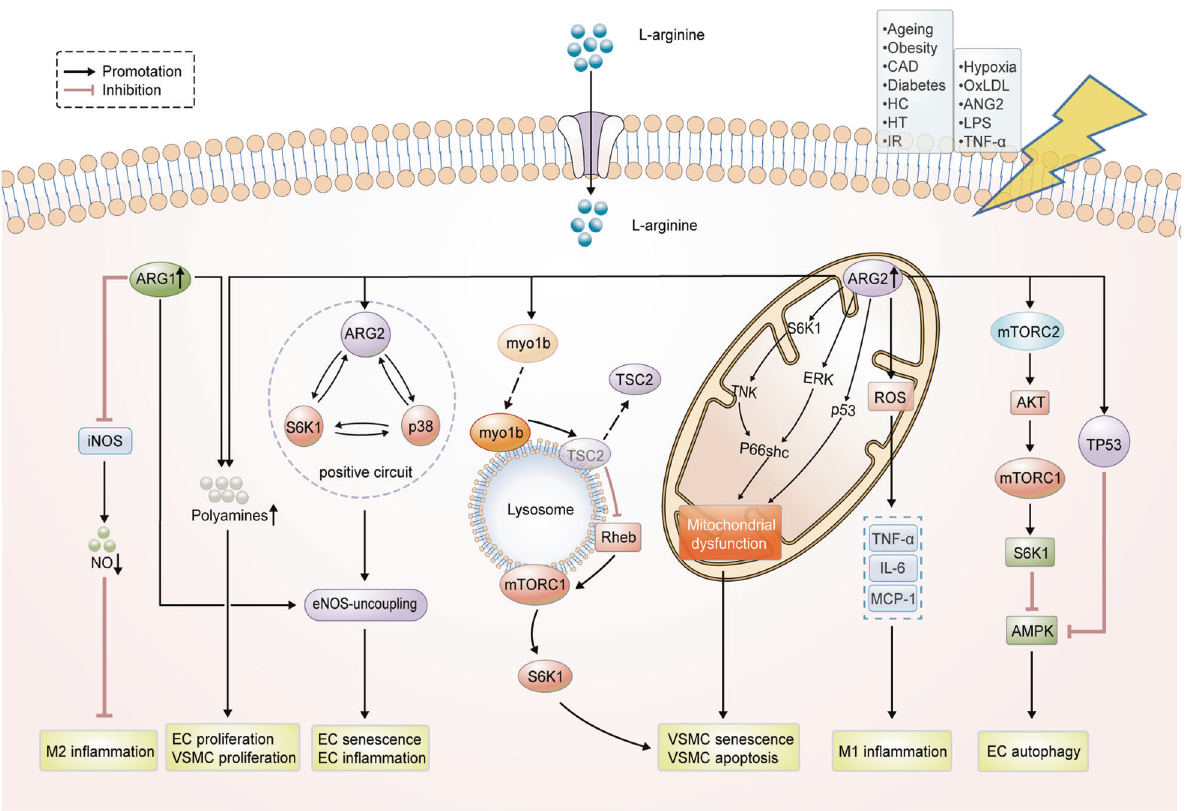
Fig. 2 Arginase regulates cellular functions in cardiovascular system through L-arginine metabolism and multiplicate signaling pathways. Arginase activity and expression can be stimulated by hypoxia, OxLDL, ANG2, LPS, TNF- α , also upregulated in ageing, obesity, CAD, diabetes, HC, HT, and IR. Both ARG1 and ARG2 can promote EC/VSMC proliferation through polyamine synthesis. ARG1 promotes M2 anti- in fl ammation response through blocking NO production from iNOS, but ARG2 induces pro-in fl ammatory cytokine production (TNF- α , IL-6, and MCP-1) in M1 via mitochondrial ROS production. ARG1 can induce EC senescence and in fl ammation through eNOS-uncoupling. The positive crosstalk of ARG2, p38MAPK, and S6K1 can accelerate vascular endothelial senescence through eNOS-uncoupling. ARG2 promotes myo1b association with lysosomes, induces lysosome re-distribution and TSC-lysosome dissociation, reliefs the inhibitory effect of TSC2 on the mTOR activator Rheb therefore actives mTORC1-S6K1 signaling, eventually leading to VSMC senescence. ARG2 promotes mitochondrial dysfunction by complex positive crosstalk among S6K1 ‐ JNK, ERK, p66Shc, and p53, leading to VSMC senescence and apoptosis. ARG2 can activate mTORC2, further activating AKT-mTORC1-S6K1 signaling and inhibiting AMPK, thereby impairing cellular autophagy. Besides, ARG2 can inhibit AMPK activation through TP53 signaling. ANG II angiotensin II, LPS lipopolysaccharide, OxLDL oxidized low-density lipoprotein, TNF- α tumor necrosis factor-alpha, CAD coronary artery disease, HC hypercholesterolemia, HT hypertension, IR ischemic reperfusion,